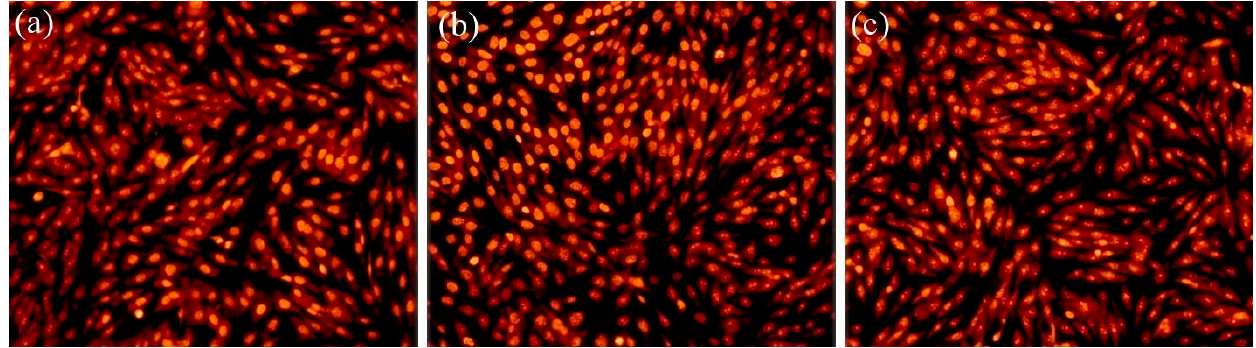
Figure 8. The morphology of MG63 (ATCC CRL1427) cells grown in the presence of the thin films (visible, 200×); control MG63 (ATCC CRL1427) cells ( a ), HAp ( b ), 0.05 AgHAp ( c ), and 0.1 AgHAp ( d ).